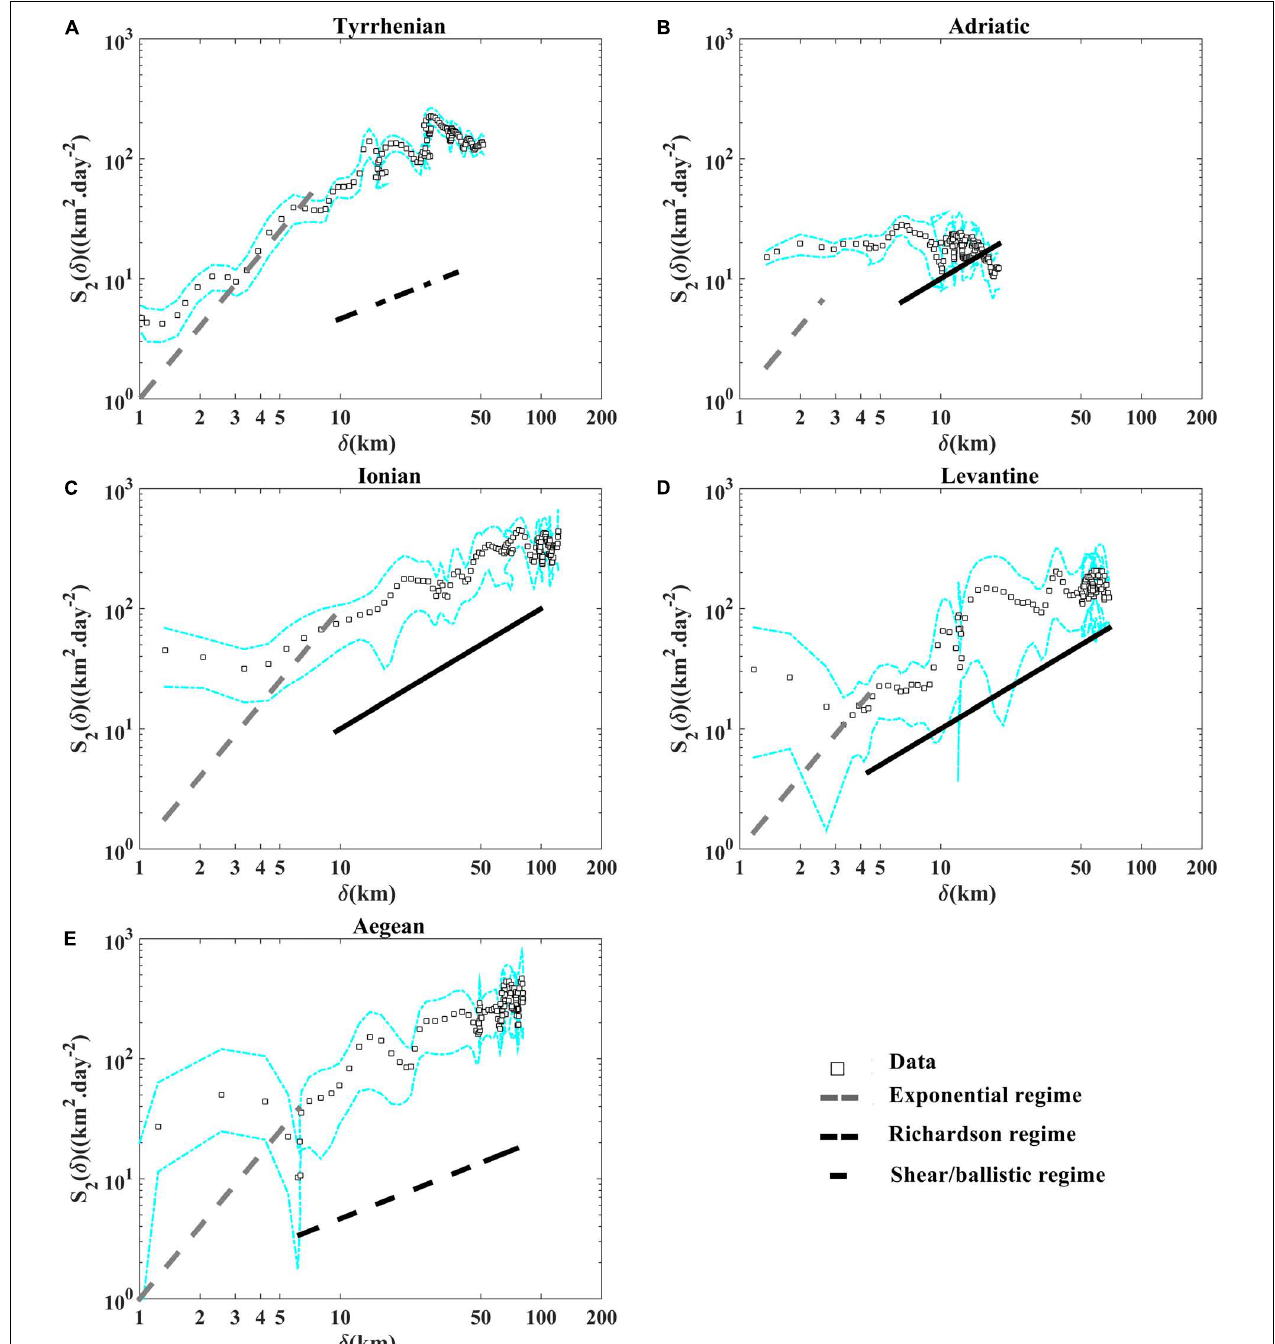
FIGURE 11 | Second-order structure function versus separation distance (A) in the Tyrrhenian, (B) the Adriatic, (C) the Ionian, (D) the Levantine, and (E) the Aegean sub-basins. The exponential, the Richardson and the shear/ballistic regimes are shown with the dashed gray, dashed black and black lines, respectively. The dashed cyan lines indicate the 90% confidence intervals from bootstrap resampling, give a rough idea of the uncertainties for the statistics.